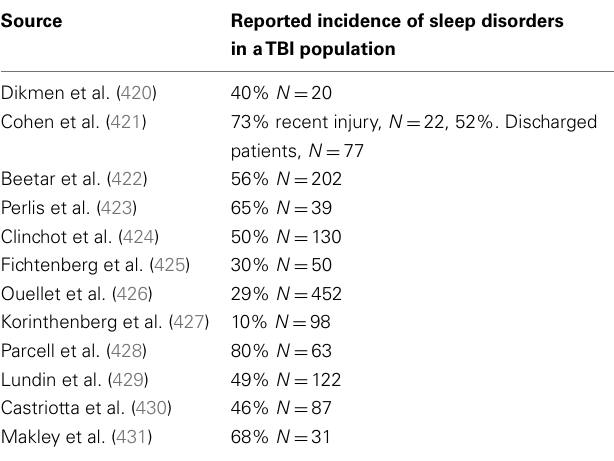
Table 11 | Incidence of sleep disorders in aTBI